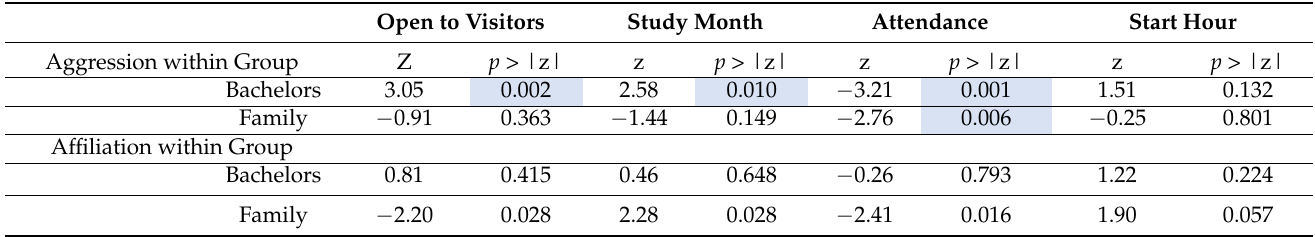
Table 4. Mixed-effect negative binomial regression of social occurrences. Input variables are shown in column headings. Input variables significantly associated with output measures are shaded in